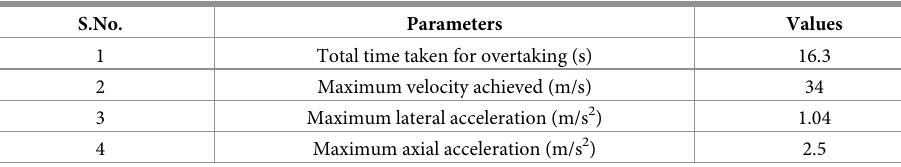
Table 1. Summarized results for scenario